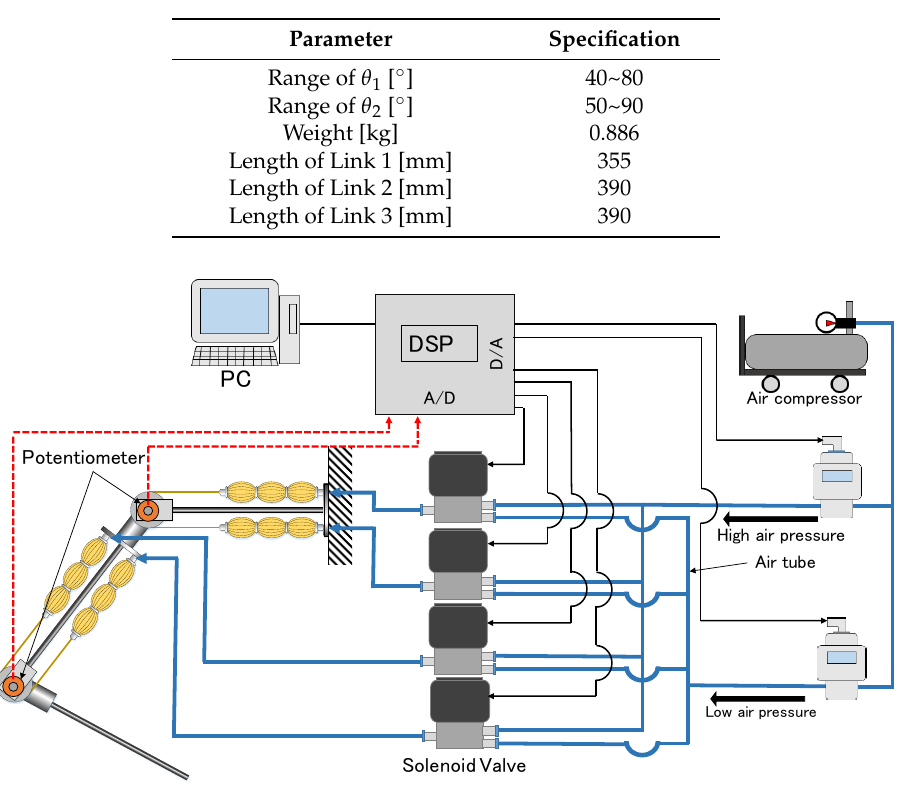
Figure 4. Schematic of the tested two-DOF robot leg with PAMs. Table 1. Specifications of the robot.